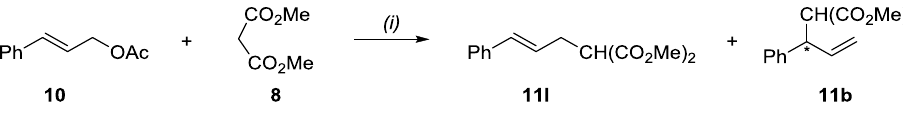
Table 2. Pd-catalyzed allylic alkylation of rac - 7 using ligands 2 and 5 . Entry